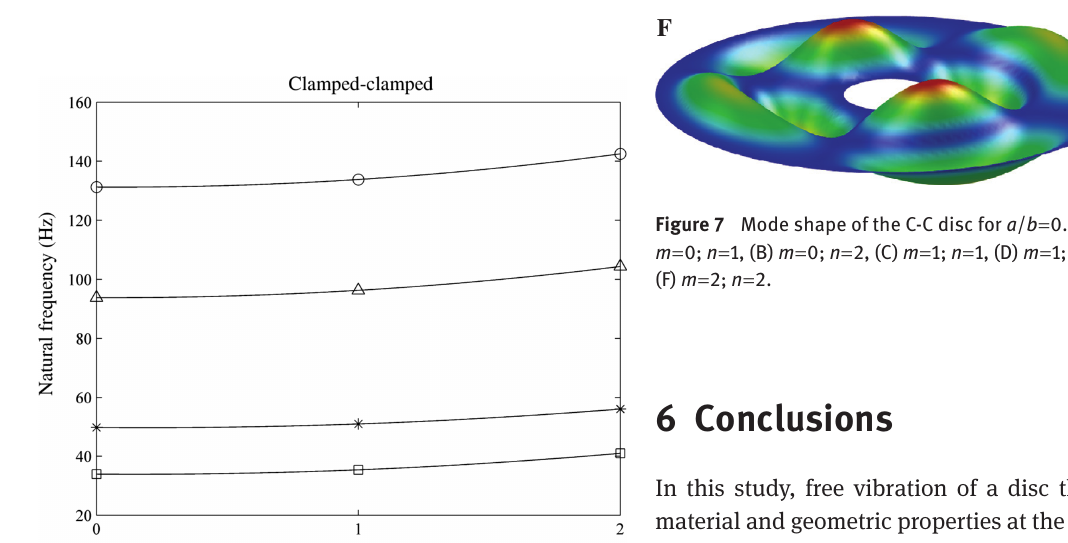
Figure 6 Comparison of variations in the natural frequencies of FGM and isotropic discs with nodal diameter ( m ) for C-C bound- ary conditions. * (FGM; n = 1), ○ (FGM; n = 2), □ (isotropic; n = 1), ∆ (isotropic; n = 2).